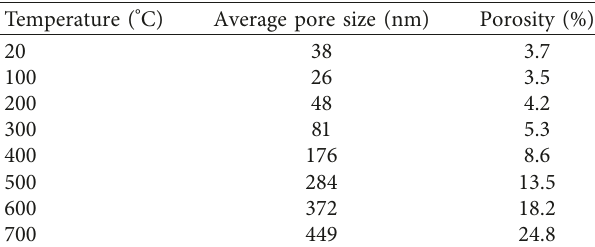
Table 6: Pore structure parameters of sandstone at various temperatures.